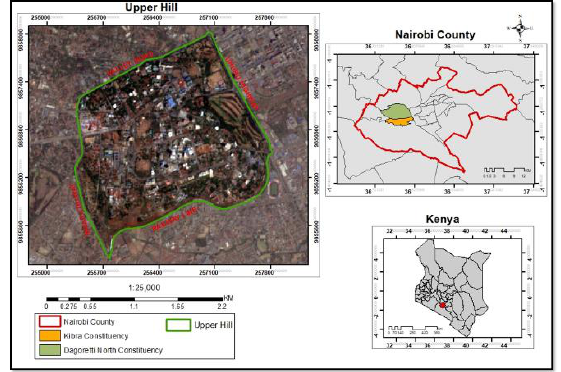
Figure 2: Location of Upper Hill in Nairobi